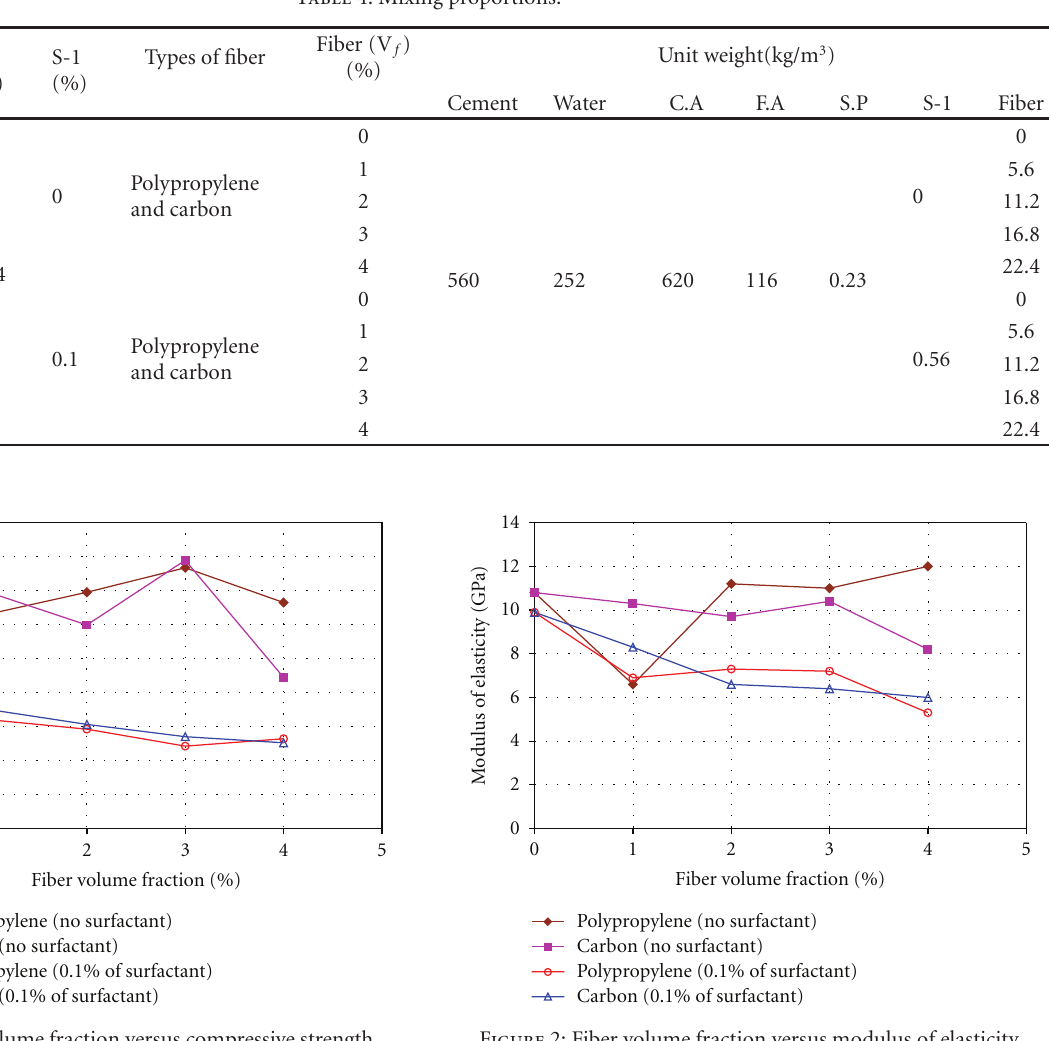
Figure 1: Fiber volume fraction versus compressive strength.